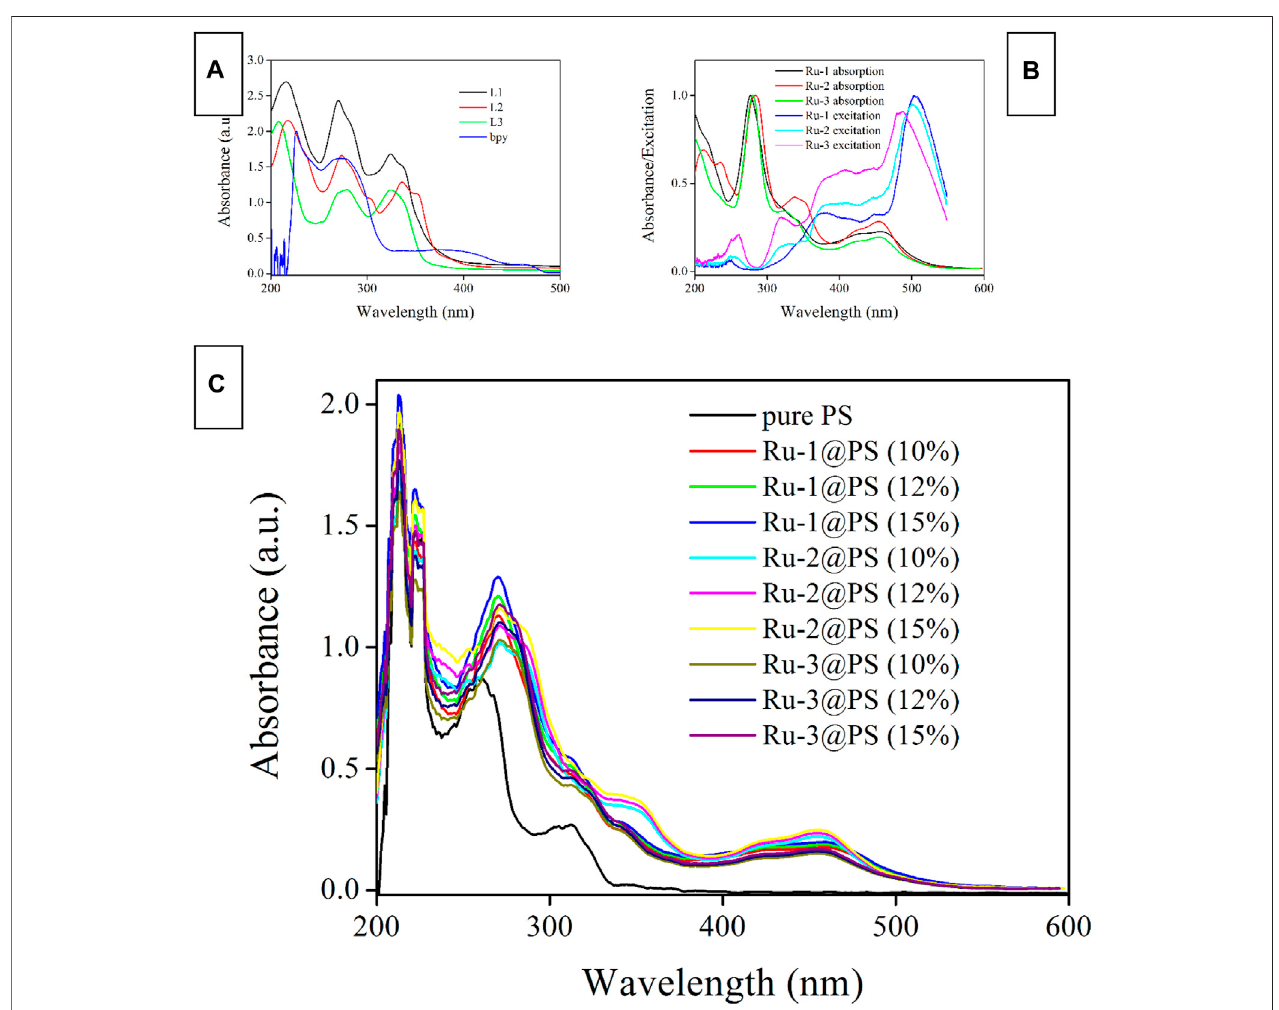
FIGURE 4 | Absorption and excitation spectra of ligands (A) and Ru-n complexes (B) in DMF (1 μ M), and absorption spectra of Ru-n@PS fi bers (C) in the solid state.